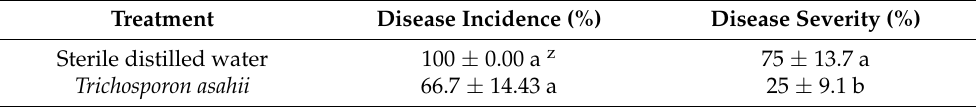
Table 6. Effects of treatments (sterile distilled water and Trichosporon asahii ) on disease incidence and severity percentage on Solo papaya ( Carica papaya L.) stored at 28 ◦ C for eight days. Treatment